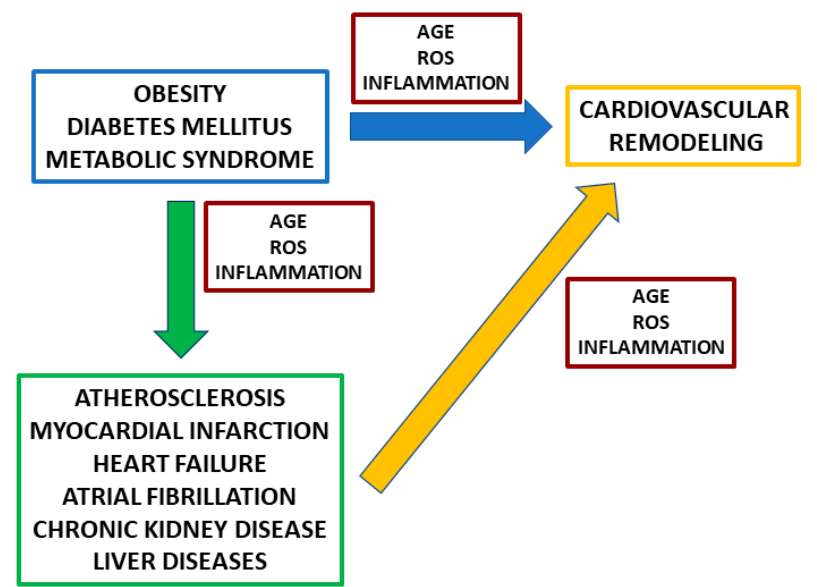
Figure 1. Metabolic disorders, advanced glycation end products (AGE), and cardiovascular remodel- ing. Obesity, diabetes mellitus, and metabolic syndrome may induce cardiovascular remodeling both directly, by inducing side effects due to the increased levels of AGE, reactive oxygen species (ROS), and inflammation, and indirectly, by promoting other disorders such as atherosclerosis, myocardial infarct, heart failure, atrial fibrillation, and kidney and liver diseases. The high levels of AGE, ROS, and inflammatory mediators that characterize these pathologies can, in turn, play additional roles in promoting cardiovascular remodeling.